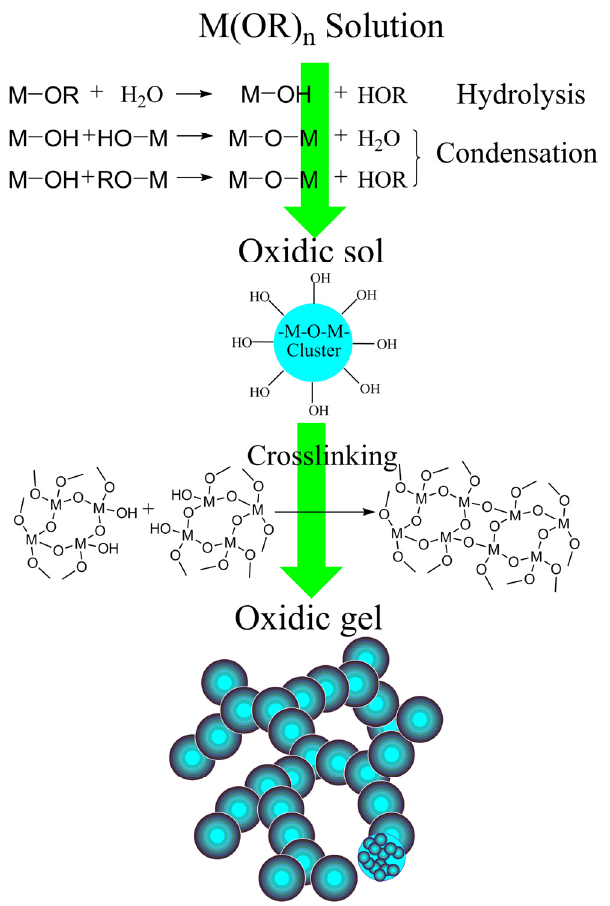
Figure 5. General scheme of traditional sol-gel